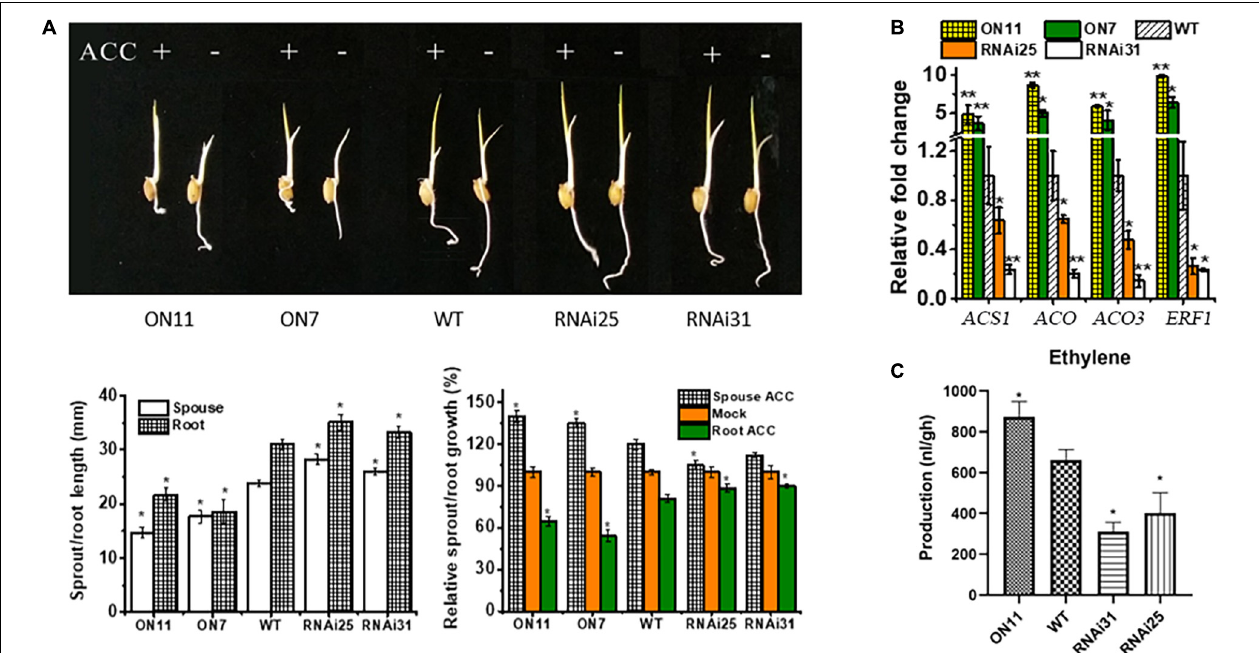
FIGURE 1 | Effects of OsNAC2 on the synthesis and response of ethylene in the OsNAC2 -transgenic lines at the seedling formation stage. (A) Phenotype of OsNAC2 -transgenic seedlings treated with 30 µ m 1-aminocyclopropane-1-carboxylic acid (ACC) for 3 days under dark. (B) Expressions of ethylene synthesis and response genes in the wild-type (WT) and OsNAC2- transgenic seedlings. The relative mRNA level was calculated using the (cid:49)(cid:49) C T method from triplicate data. OsActin was used as internal control to normalize the various samples with the same amount of plant RNA. (C) Ethylene production of WT and transgenic seedlings. Data are presented as the mean ± standard error of at least three biological replicates. Asterisks indicate significant differences between treatment and control by t -test. * p < 0.05, ** p < 0.01, and ** p < 0.001.